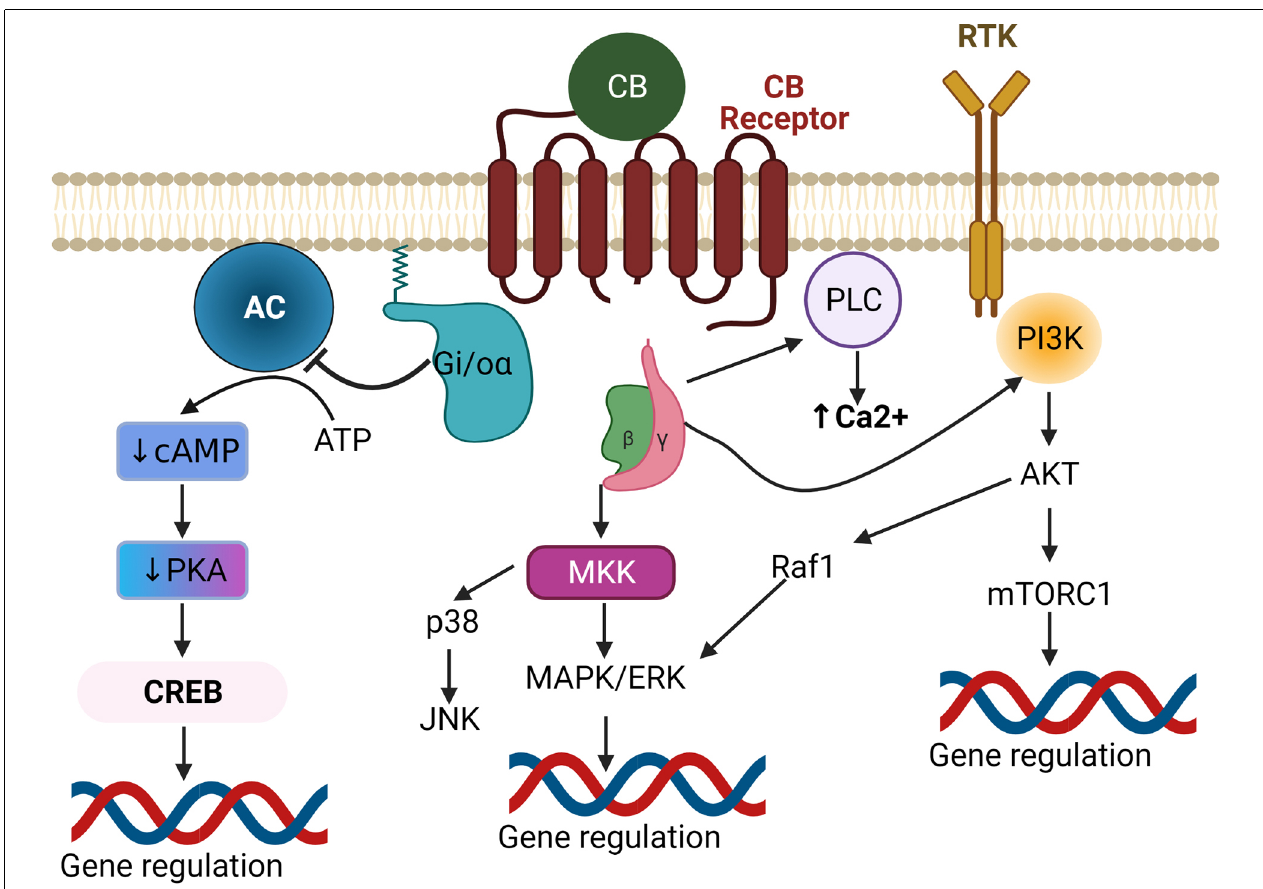
FIGURE 2 | Canonical endocannabinoid signaling pathways. Upon binding of a CB ligand to a Gi/o-coupled GPCR, the Gi/o- α receptor subunit gets detached from the βγ subunits. The liberated Gi/o- α inhibits adenylate cyclase (AC) causing subsequent decreases in cAMP-mediated PKA and CREB activation, leading to downregulation of CREB-induced gene expression. The βγ subunits activate either MAPK or PI3K to regulate gene expression. Alternatively, they can also regulate Ca 2 + levels via activation of PLC. Inhibition of PKA can also affect other MAPK pathways (not shown). Abbreviations: GPCR, G protein-coupled receptors; AC, Adenylate Cyclase; cAMP, Cyclic adenosine monophosphate; PKA, Protein Kinase A; CREB, cAMP response element-binding protein; MKK, MAP kinase kinase; MAPK, Mitogen-activated protein kinase; ERK, Extracellular signal-related kinase; JNK, c-Jun N-terminal kinase; Raf1, Rapidly Accelerated Fibrosarcoma1; PI3K, Phosphoinositide 3-kinases; Akt, Protein kinase B; mTORC1, mammalian target of rapamycin complex 1; PLC, Phospholipase